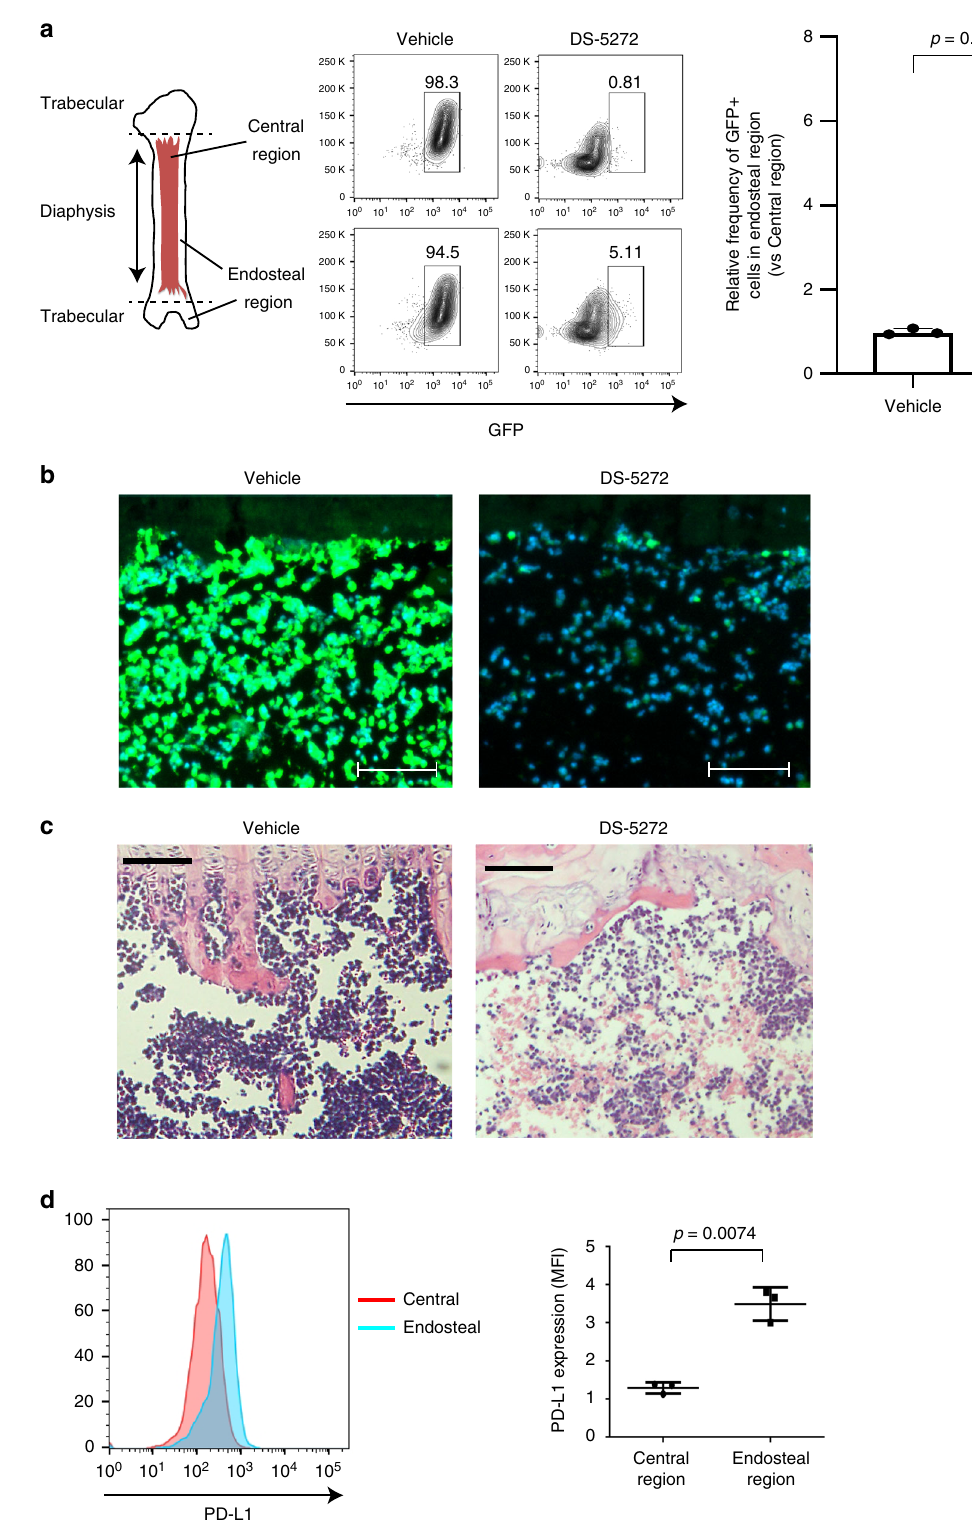
data suggest that NK cells are important mediators of antileu- kemia immunity during the treatment with DS-5272. Hif1 α -PD-L1 axis limits the antileukemia effect of p53 . Based on data described above, we hypothesized that AML cells expressing high levels of Hif1 α and PD-L1 could evade